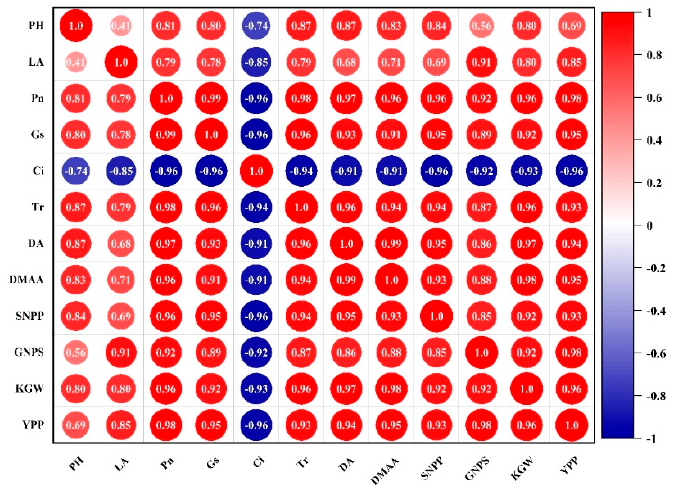
Figure 4. Correlation analysis of morphological traits, photosynthesis, dry matter assimilation and transportation with yield. Abbreviations: PH: plant height at the grain-filling stage; LA: leaf area at the grain-filling stage; Pn: the net photosynthetic rate at the grain-filling stage; Gs: stomatal conductance at the grain-filling stage; Ci: intercellular carbon-dioxide concentration at the grain- filling stage; Tr: transpiration rate at the grain-filling stage; DA: dry matter accumulation in maturity stage; DMAA: dry matter accumulation of vegetative organs after flowering stage; SNPP: spike number per plant; GNPS: grain number per spike; TGW: 1000-grain weight; YPP: yield per